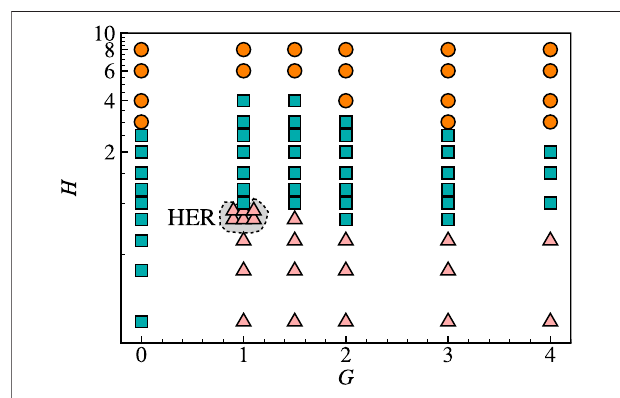
FIGURE 7 | Overview of the typical mode regions on the G - H plane for the three fl ags in left triangle con fi gurations. The symbols △ , □ and ○ denote the regular-coupled (RC), irregular-coupled (IC) and decoupled (DC) modes, respectively. The harvest enhancementregion(HER),where theaverage bendingenergyofthesystemisenhancedduetothefavorablearrangements. The other governing parameters are as follows: Re =200, M =2.9, K =0.3 and S =1,000.